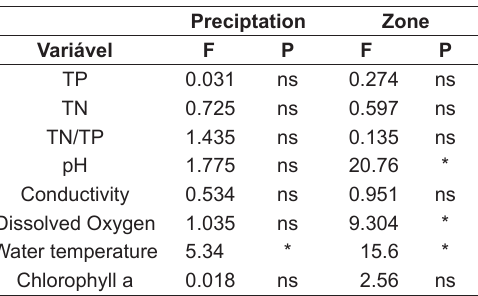
Table 2. ANCOVA synthesis to detect if the differ- ences among abiotic variables and chlorophyll- a between both aphotic and photic zones were influenced by the